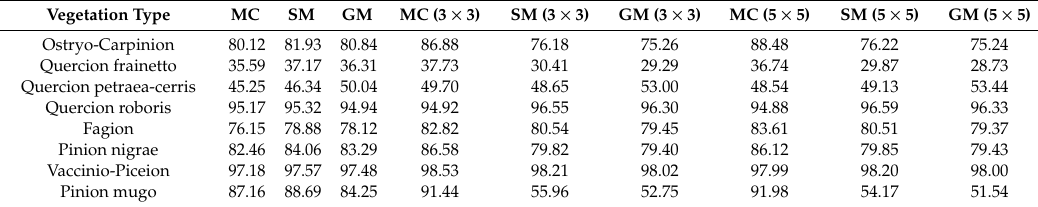
Table A2. Producer’s accuracy for all woody vegetation classes for 5-fold LLOCV.